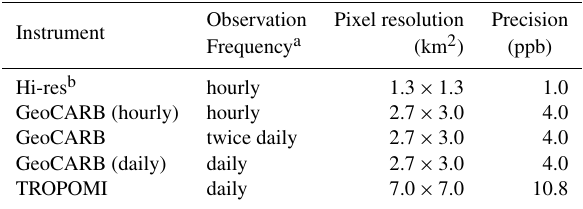
Table 1. Satellite observing systems considered in this work.